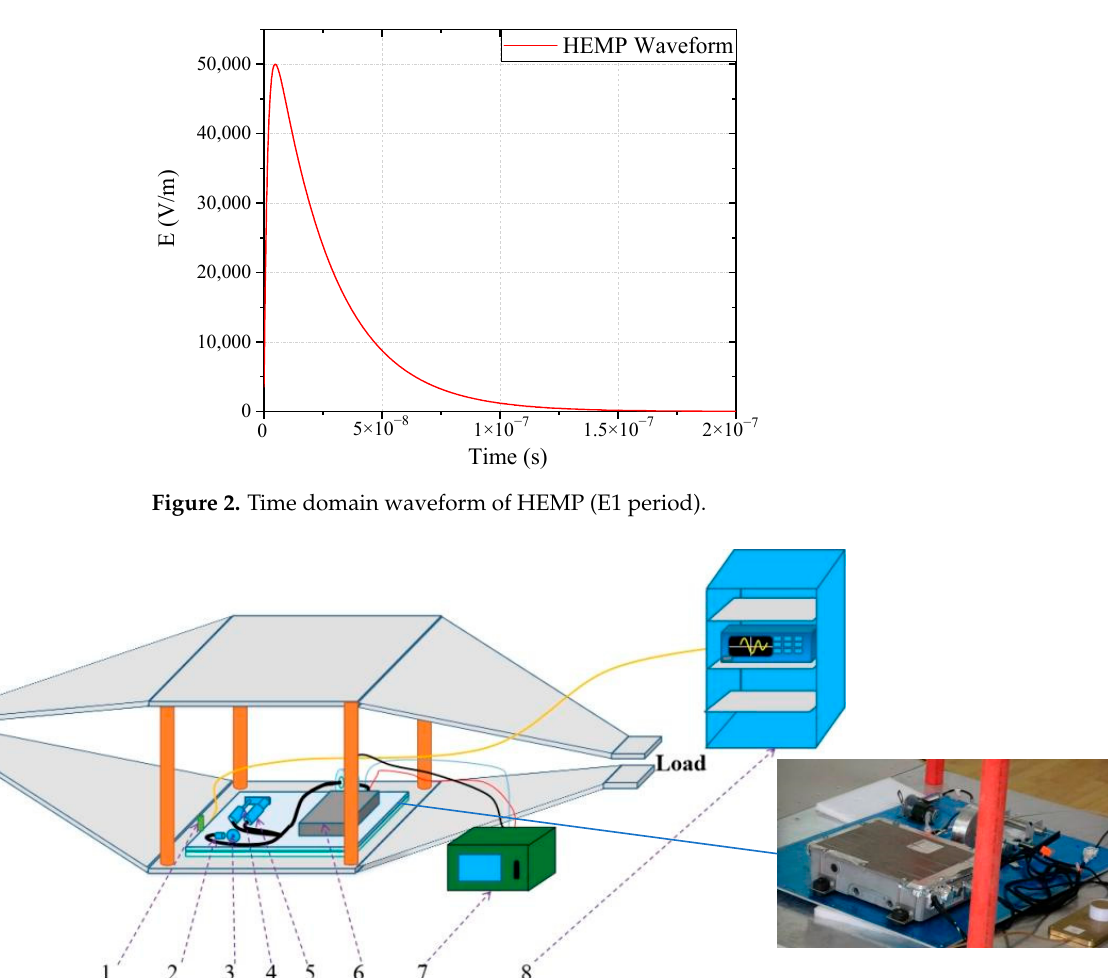
Figure 3. Main fuel regulation control system in the radiation test: 1—Field monitoring probe; 2— Speed sensor; 3—Phonic wheel; 4—LVDT; 5—Linear motor; 6—Controller; 7—Shielding box; 8— Shielding cabinet.